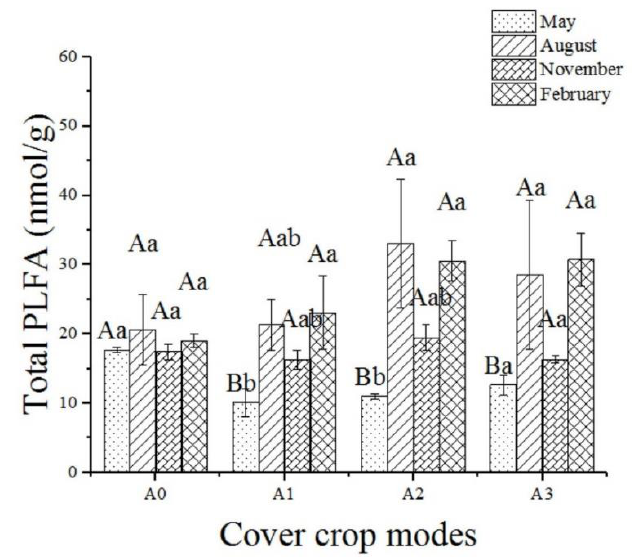
Figure 4. Variation of the total phospholipid fatty acids (PLFAs) in microorganisms. Different capital letters indicate the significant differences between different cover crop patterns in the same month, and different lowercase letters indicate the significant differences between different months in the same cover crop patterns ( p < 0.05).